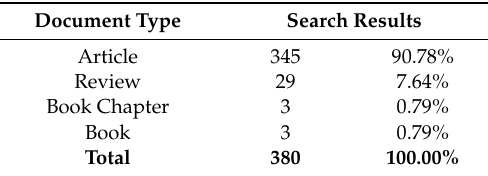
Table 1. Document types.